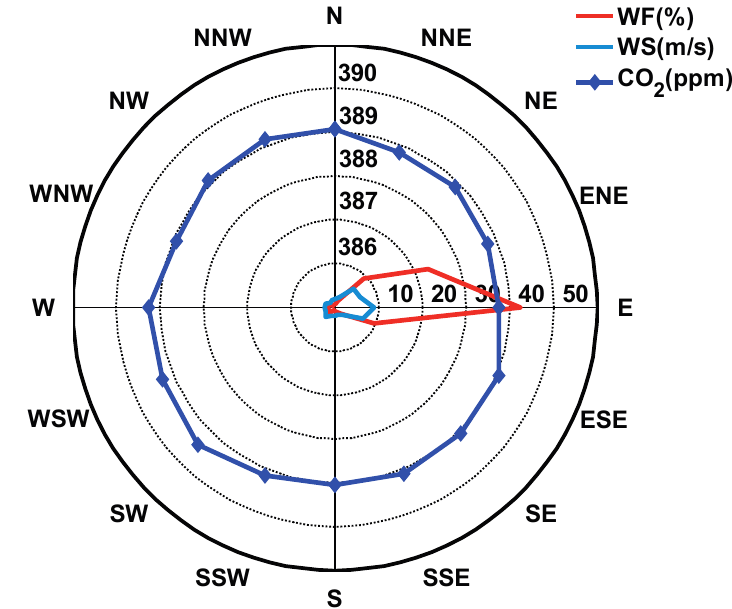
Figure 3. Wind Frequency, Wind Speed and CO (2010 through 2013). Scale 10–50 is used for WF and WS and Scale 386–390 for CO